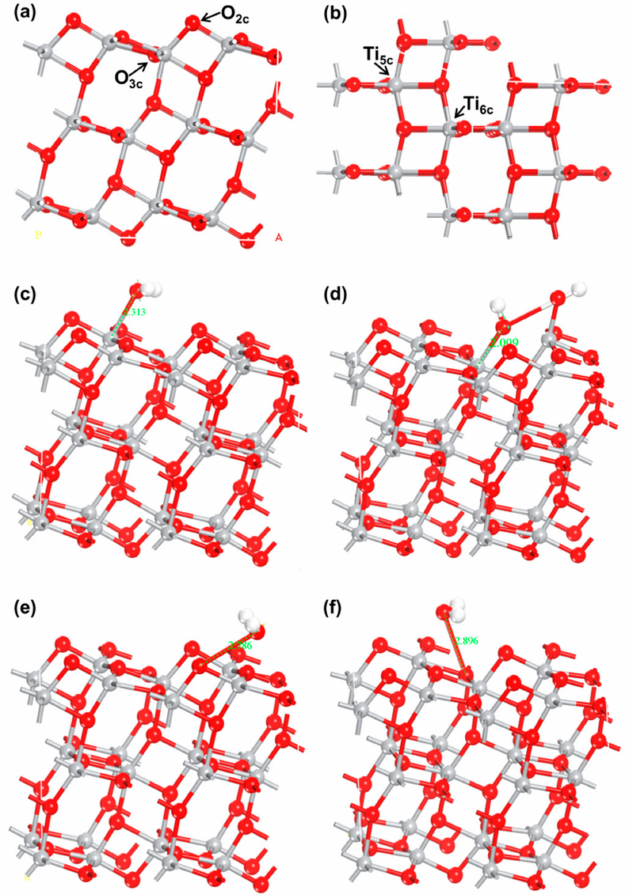
Figure 7. ( a ) Side view and ( b ) top view of optimized structures of anatase TiO 2 (101) surfaces. Visualization of water-anatase TiO 2 (101) configuration models with various adsorption sites: ( c ) Ti 5c , ( d ) Ti 6c , ( e ) O 2c , and ( f ) O 3c